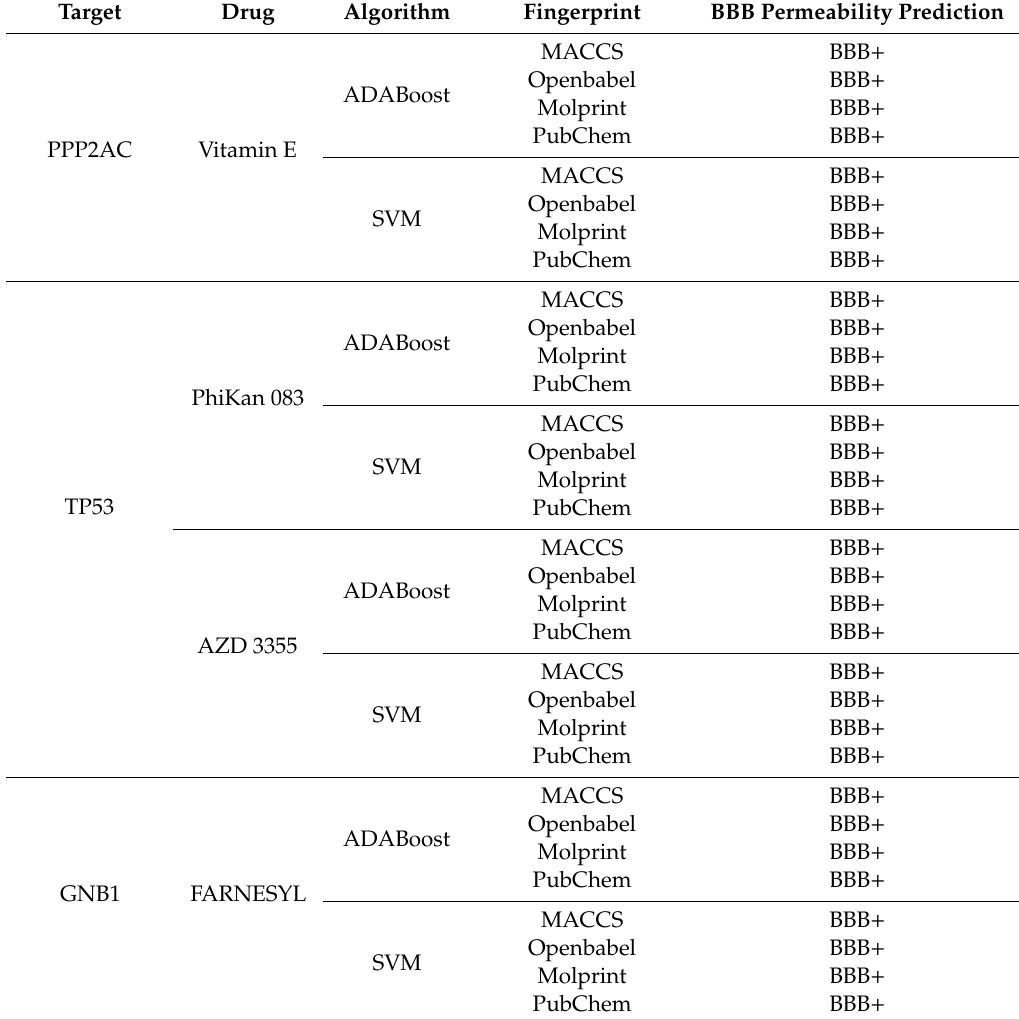
Table 2. Drugs that interact with components of the SCA1 protein network and are predicted to penetrate the blood brain